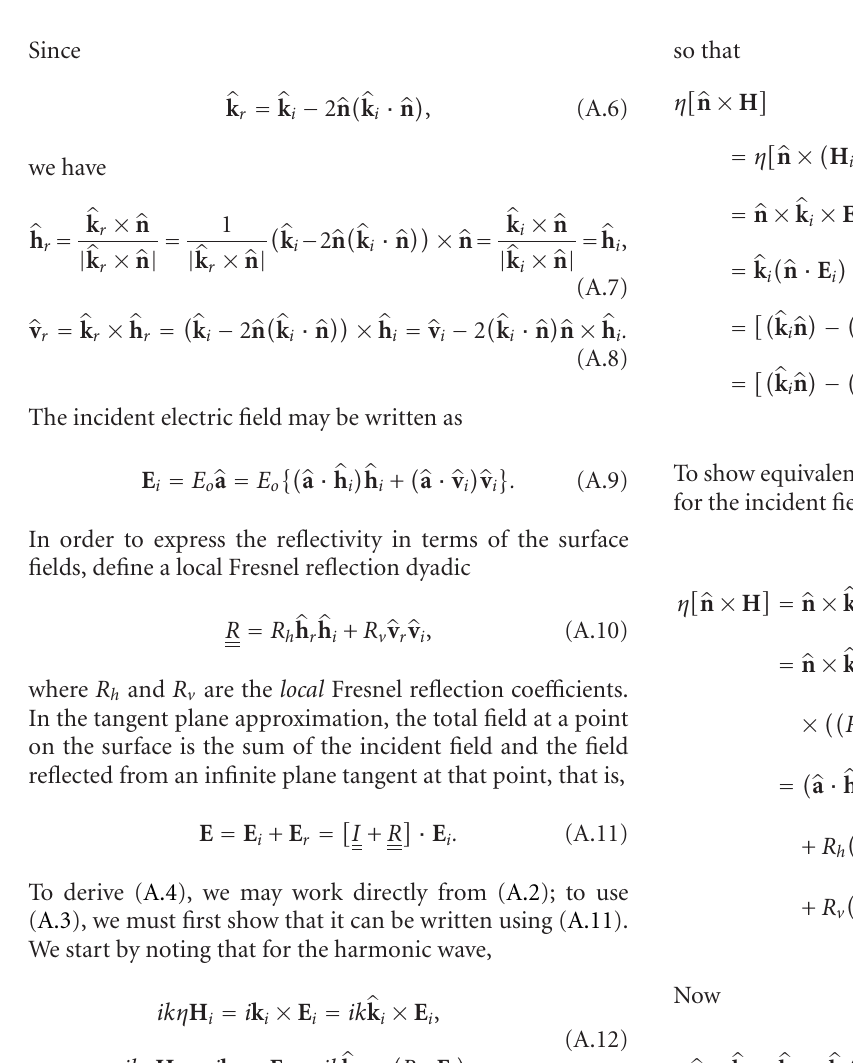
Figure 7: (a) Comparison of simulated coherence PDFs with that observed for the passage of a vehicle over a surface as reported in [27]. The coherence image from which the observed distribution has been obtained is shown in (b), wherein tyre tracks are clearly discernible by